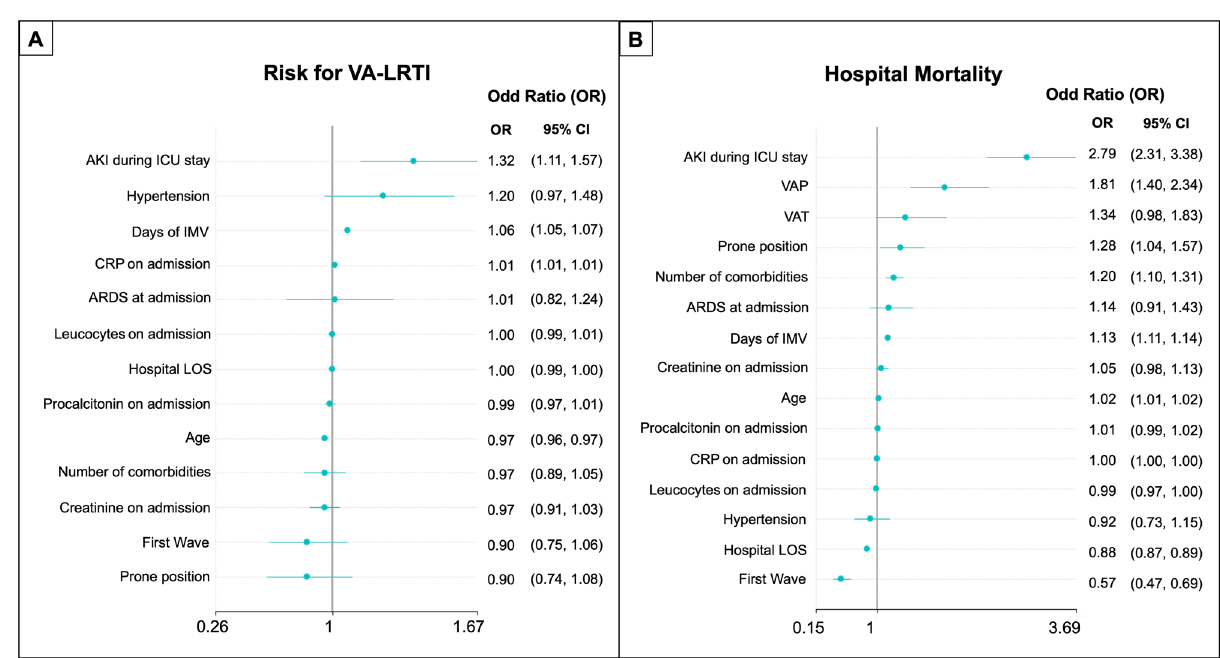
Figure 4. Logistic regression models to identify factors associated with ventilator-associated lower respiratory tract infection (VA-LRTI) ( A ) and the impact of VA-LRTI on hospital mortality ( B ). Logistic regression was performed with the optimal subset of variables obtained with the random forest model for the two outcomes (VA-LRTI and hospital mortality). The odds ratios (OR) are graphically represented in the Forest plot for better medical interpretability. ( A ) Presents the odd proportions of the risk for VA-LRTI, and ( B ) is shown the odds ratios for the hospital